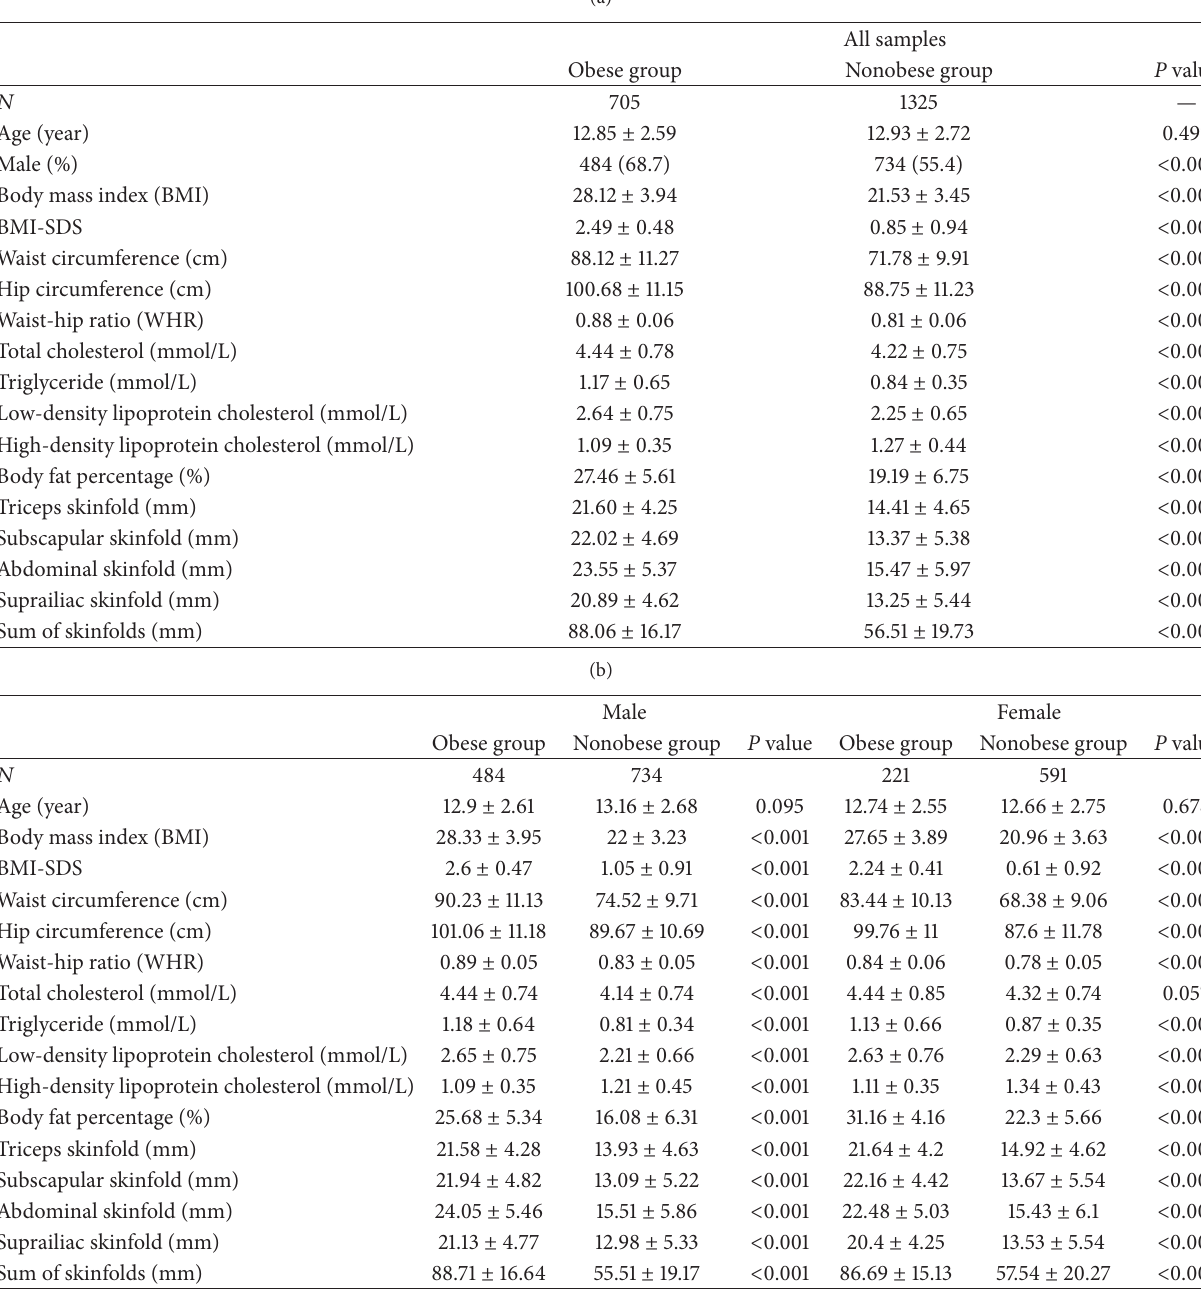
Table 1: (a) General characteristics of the study groups. (b) General characteristics of the study groups in boys or